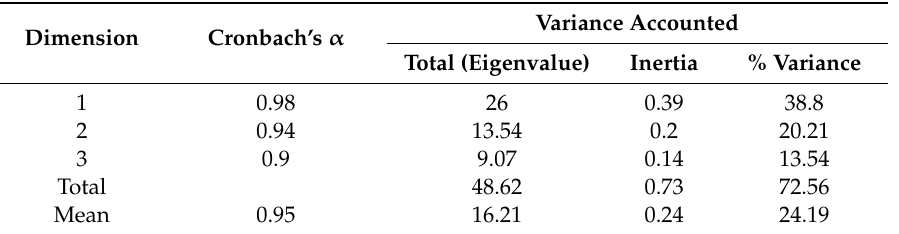
Table 6. Summary of the model.